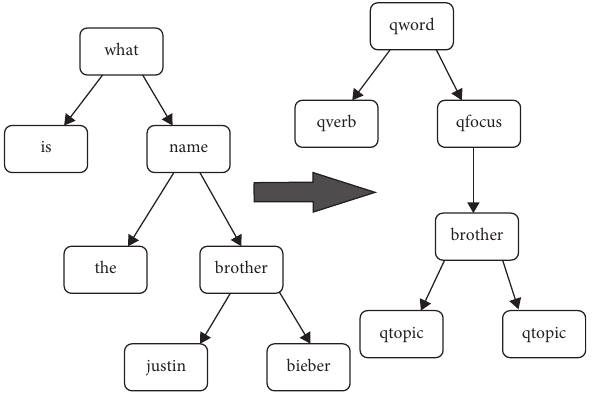
Figure 8: Information extraction diagram based on artificial intelligence technology. Table 2: Comparison of the extraction speed of interactive elements through different methods.